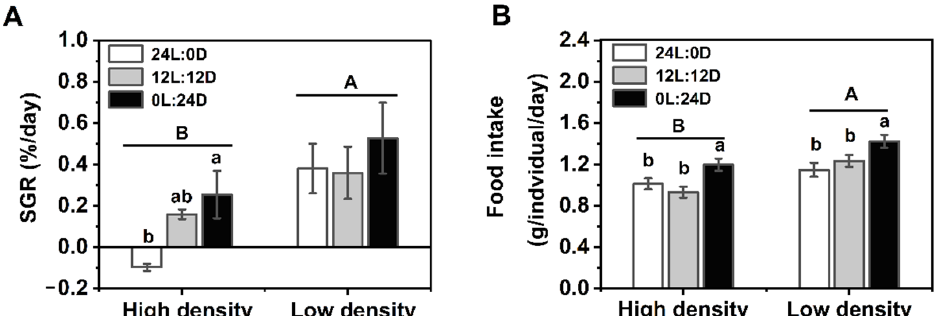
Figure 2. Effects of density and photoperiod on SGR ( A ) and food intake ( B ) of Pelodiscus sinensis . Data are n = 24 under high density and n = 12 under low density for SGR, n = 13 for all groups in food intake. Data are presented as the mean ± S.E. Different lowercase letters denote a statistically significant difference among different photoperiods under each density, and different capital letters indicate a significant difference between different densities ( p < 0.05).